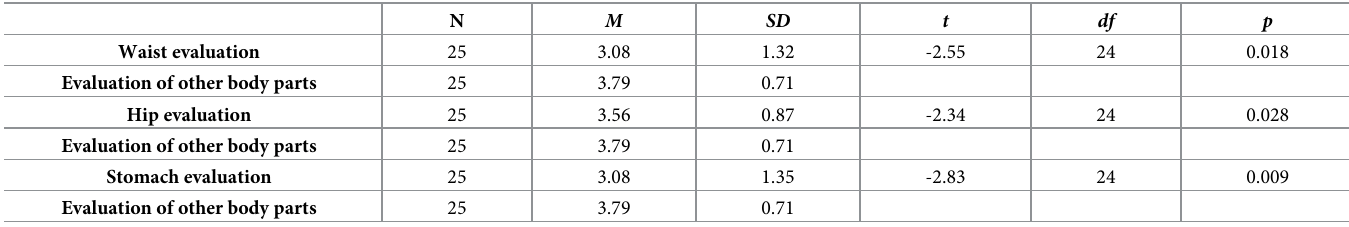
Table 2. Differences in evaluation of waist, hips and stomach image as compared to other body parts in the whole sample. N M SD Waist